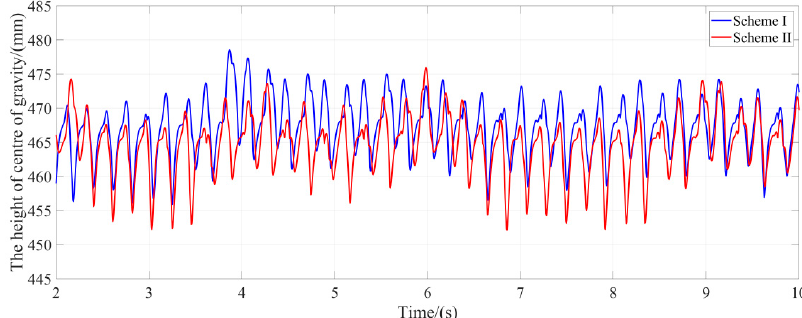
Figure 16. Simulation results with Webots for the height of the center of mass (CoM).